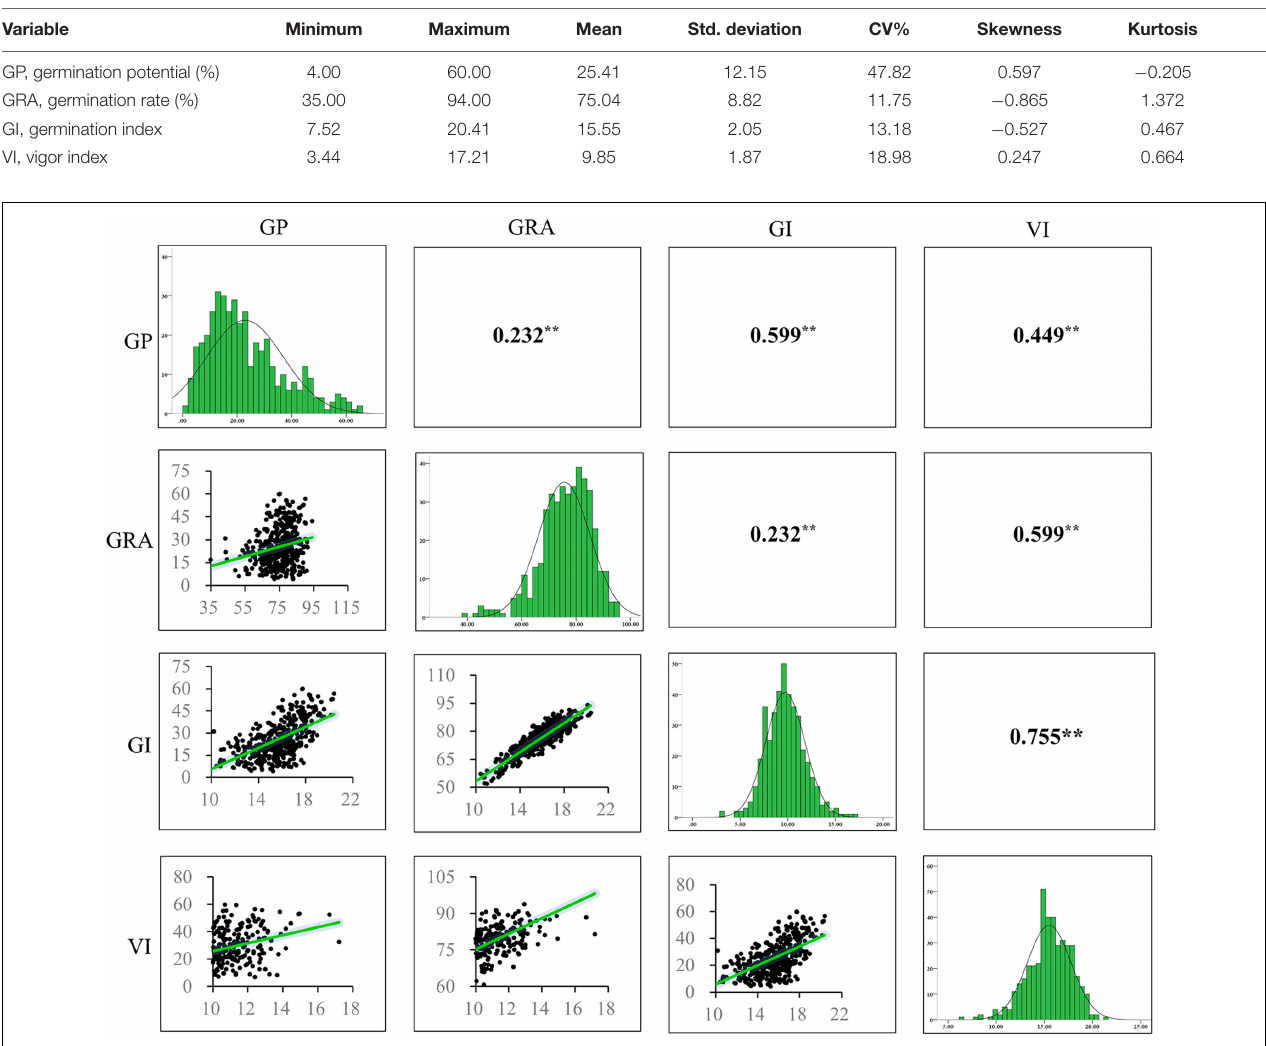
TABLE 1 | Phenotypic variation statistics for seed germination traits.